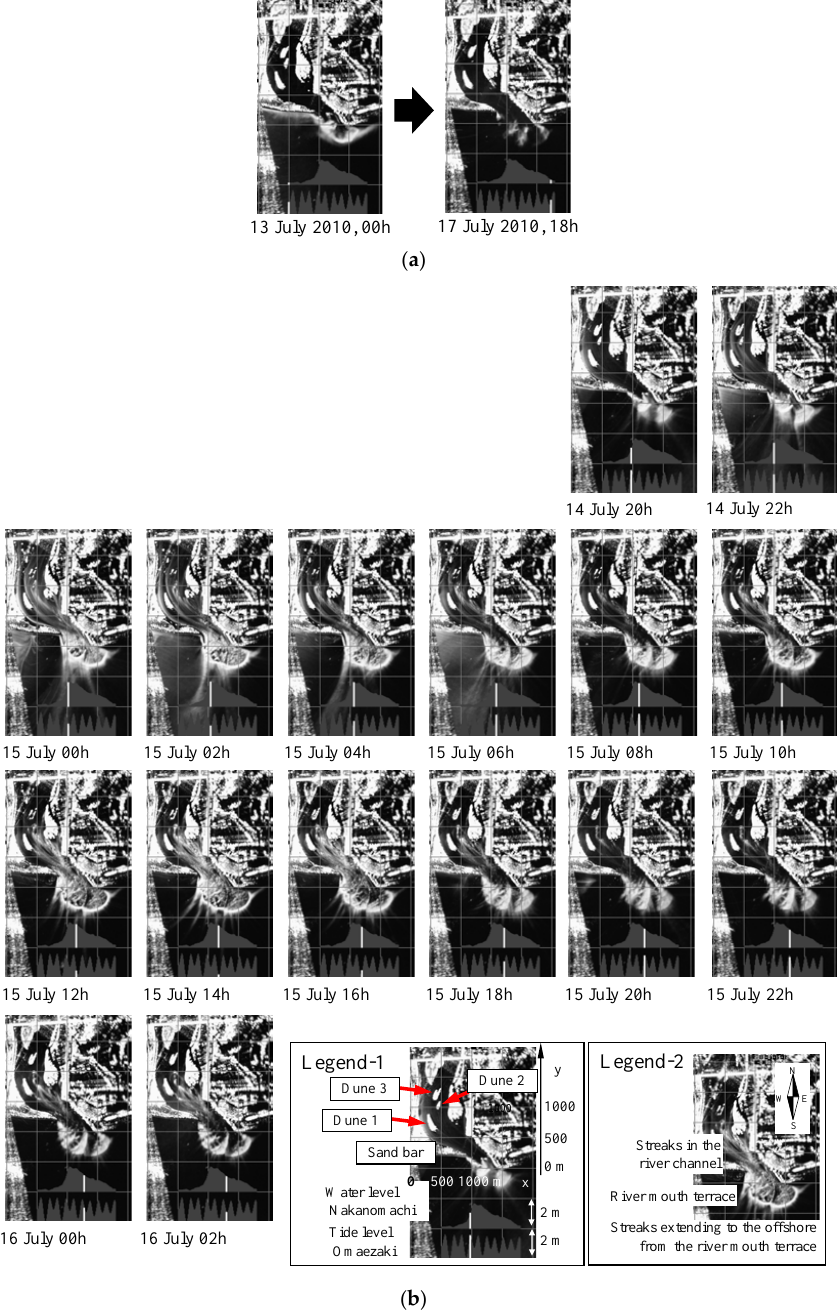
Figure 3. ( a ) Time-averaged images during the flood. Pre-flood: 13 July 2010, 00 h JST. Post-flood: 17 July 2010, 23 h JST. The lower portion of each image shows the water level variations measured at the Nakanomachi station in the river and the Omaezaki tide level station. The white vertical line in this lower portion denotes the temporal position in the radar acquisition; ( b ) Time-averaged images during the flood. From 14 July 2010, 20 h to 16 July 2010, 02 h.